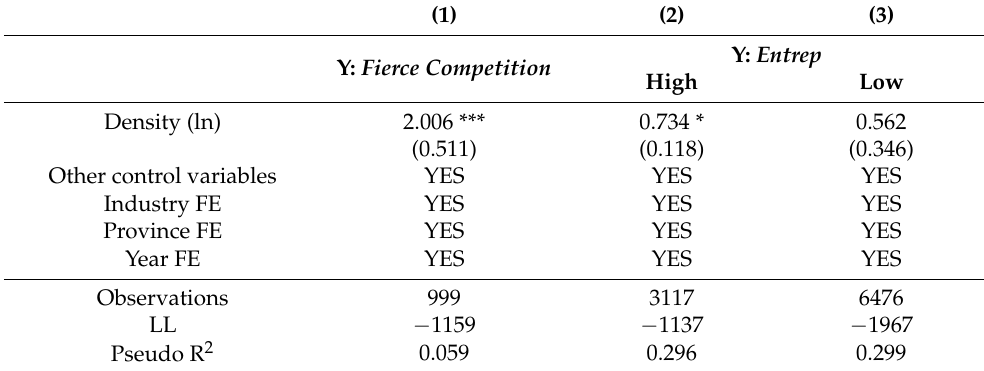
Table 7. Agglomeration economies and entrepreneurship: testing the effect of